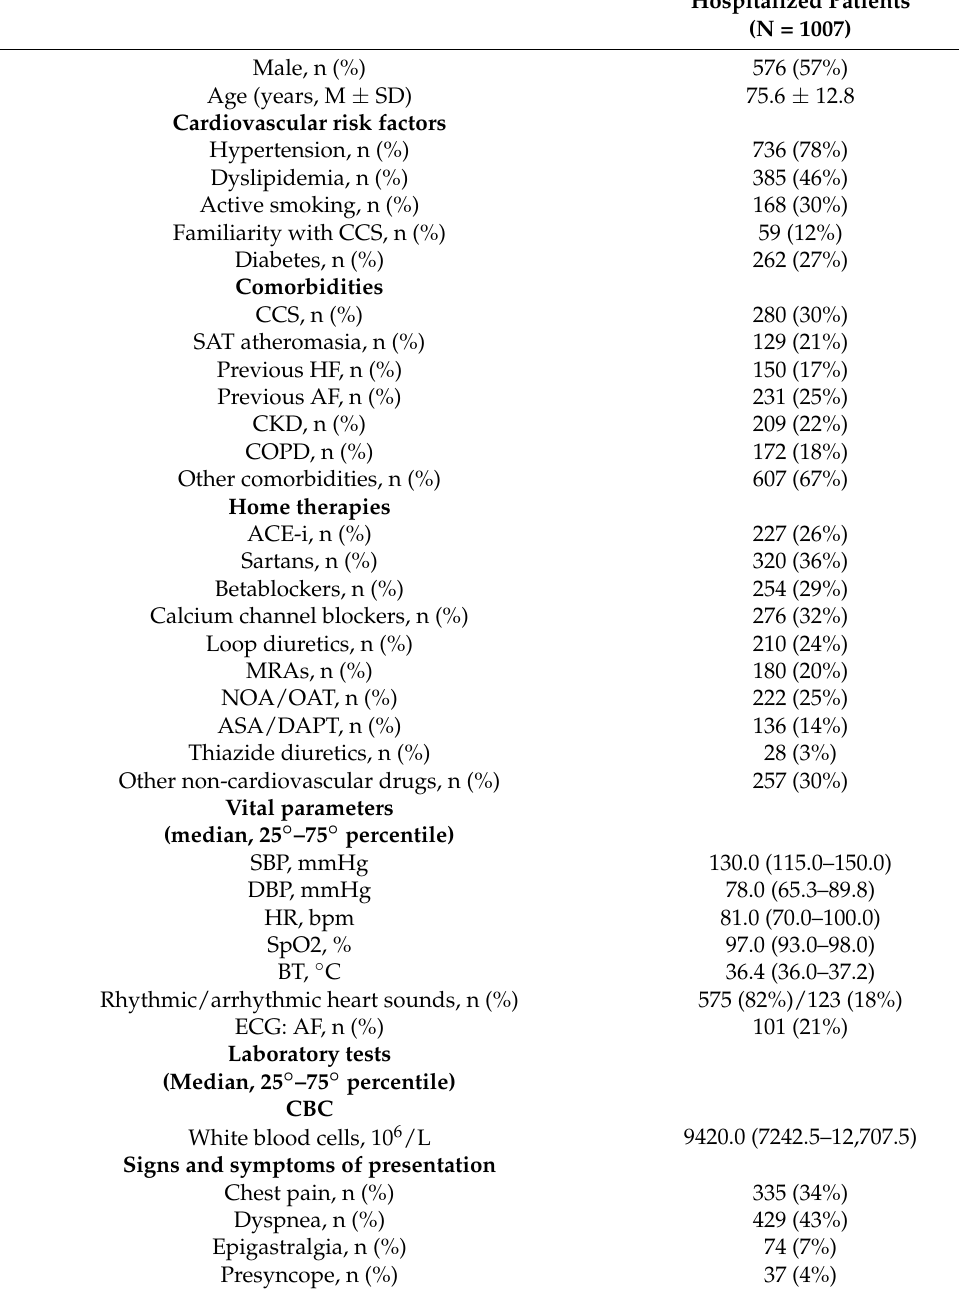
Table 1. Demographic, clinical features and lab results of the investigated patient